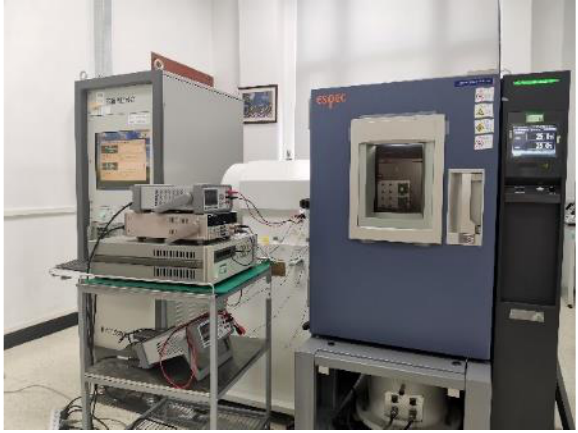
Figure 6. The measuring system.